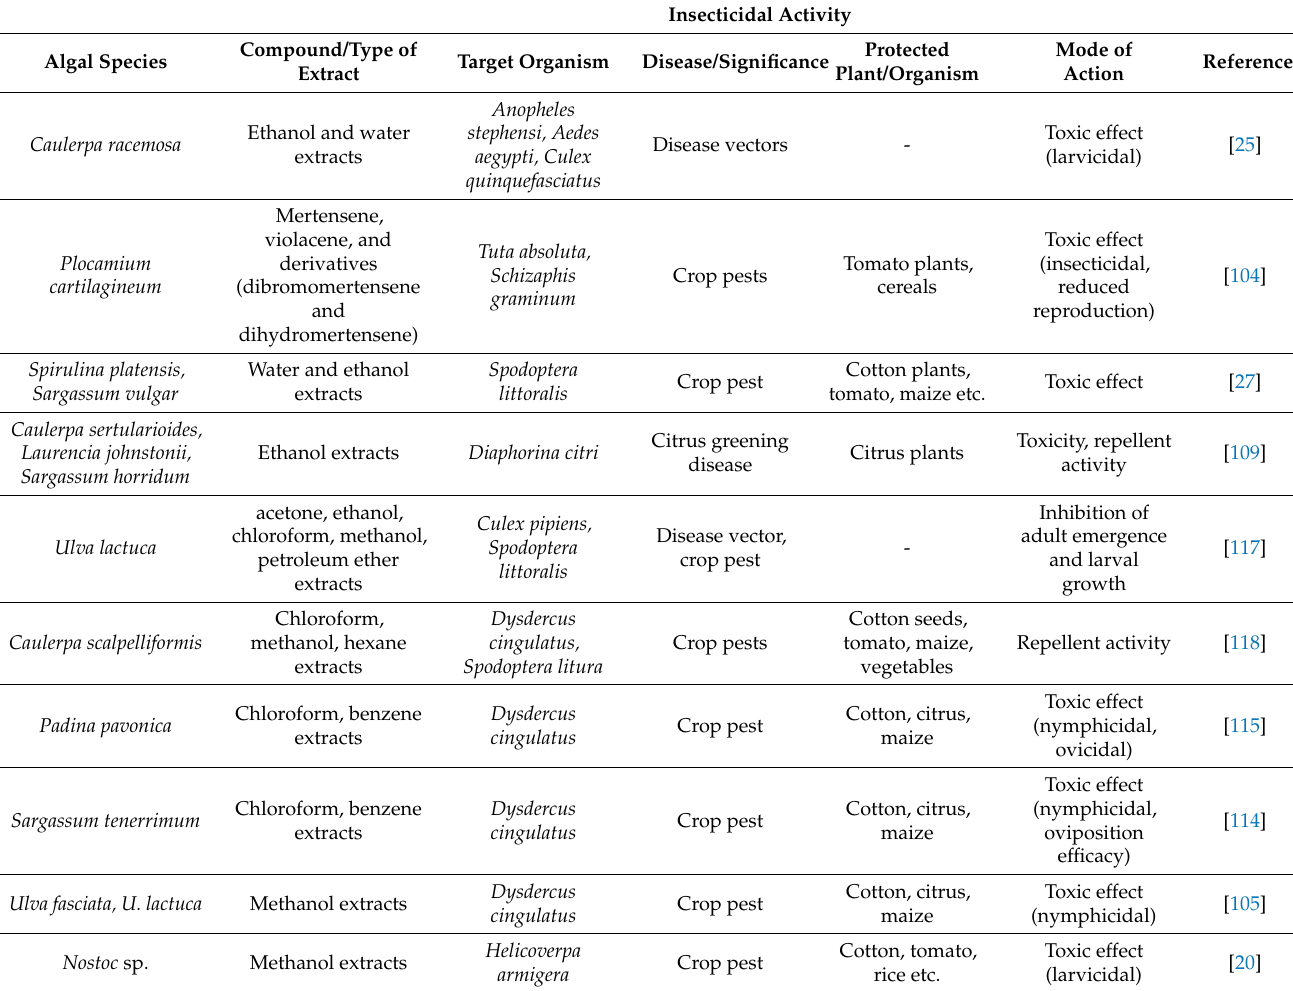
Table 5. Summary of algal products and their activity against insects and